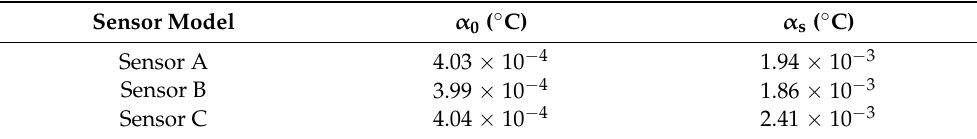
Table 4. Drift parameters of sensors before